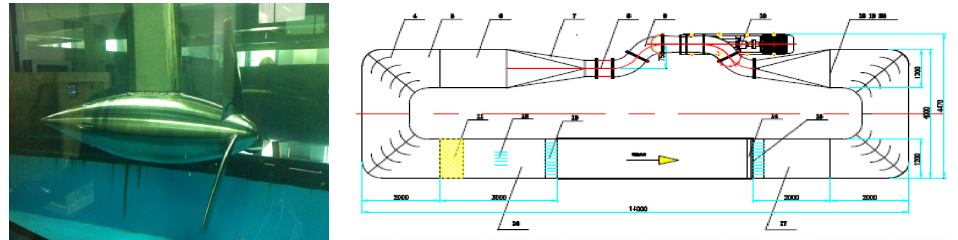
Figure 35. Experimental TCPGS developed by Shanghai Maritime University, University of Brest and French Naval Academy.